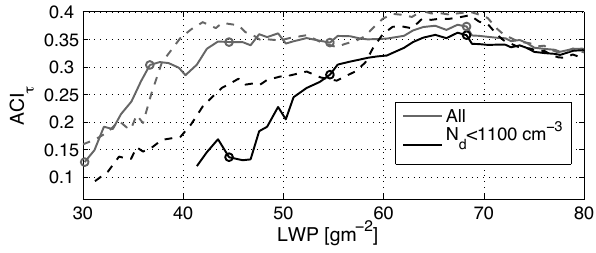
Figure 12: ACI τ as a function of LWP bins. Cases with N d smaller than 1100cm − 3 and irrespective of N d are denoted by black and gray lines, respectively. Dashed lines indicate ACI τ calculated with a 15-second running mean LWP and N a . Values are statistically significant according to a Student’s t test at the 99% confidence level. Circles indicate bins without overlapping.